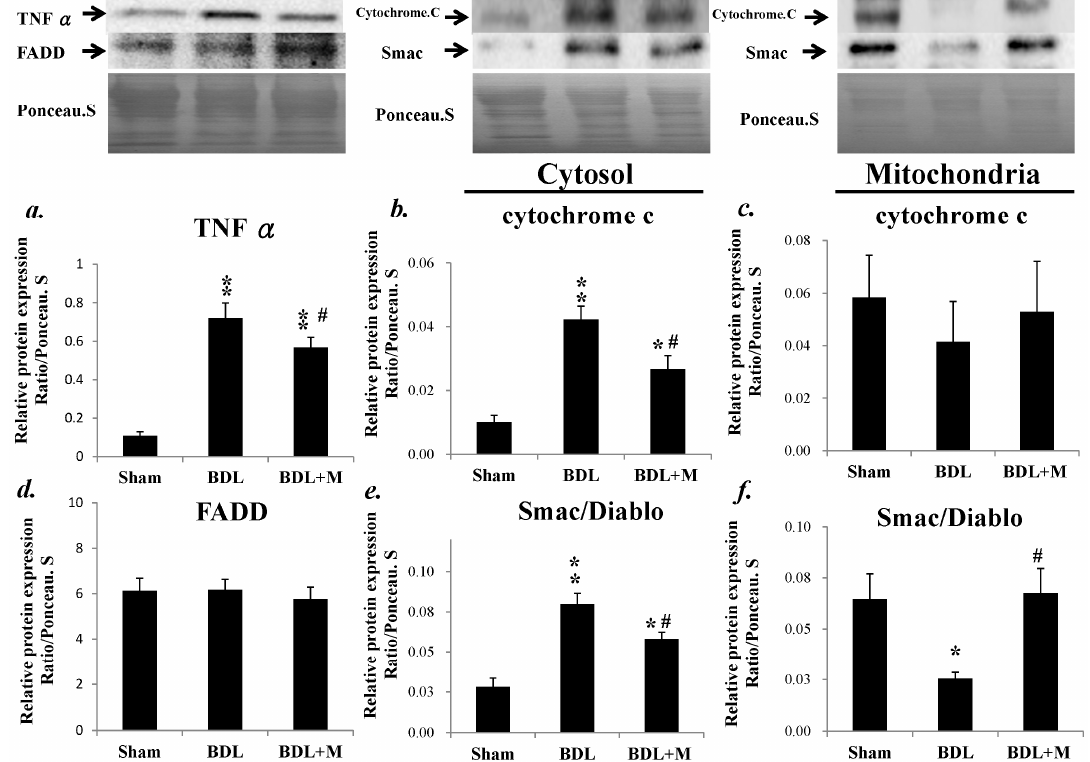
Figure 6. ( a ) BDL for two weeks increased TNF- α protein expression while melatonin treatment reduced this effect; ( b ) cytosolic cytochrome c was highly expressed in response to BDL and melatonin treatment rescued this process; ( c ) mitochondrial cytochrome c was decreased in response to BDL; ( d ) Fas-Associated protein with Death Domain (FADD) was not affected by BDL or melatonin treatment; ( e ) cytosolic second mitochondria-derived activator of caspase/direct inhibitor of apoptosis-binding protein with low pl (Smac/Diablo) was increased after BDL and melatonin effectively reversed the effect; and ( f ) mitochondrial Smac/Diabo change was not reversed by melatonin treatment. Significant difference among three groups was analyzed by one-way ANOVA followed by Bonferroni post hoc. All data are shown as mean ± SEM. * p < 0.05 vs. Sham; ** p < 0.01 vs. BDL; # p < 0.05 vs. BDL.